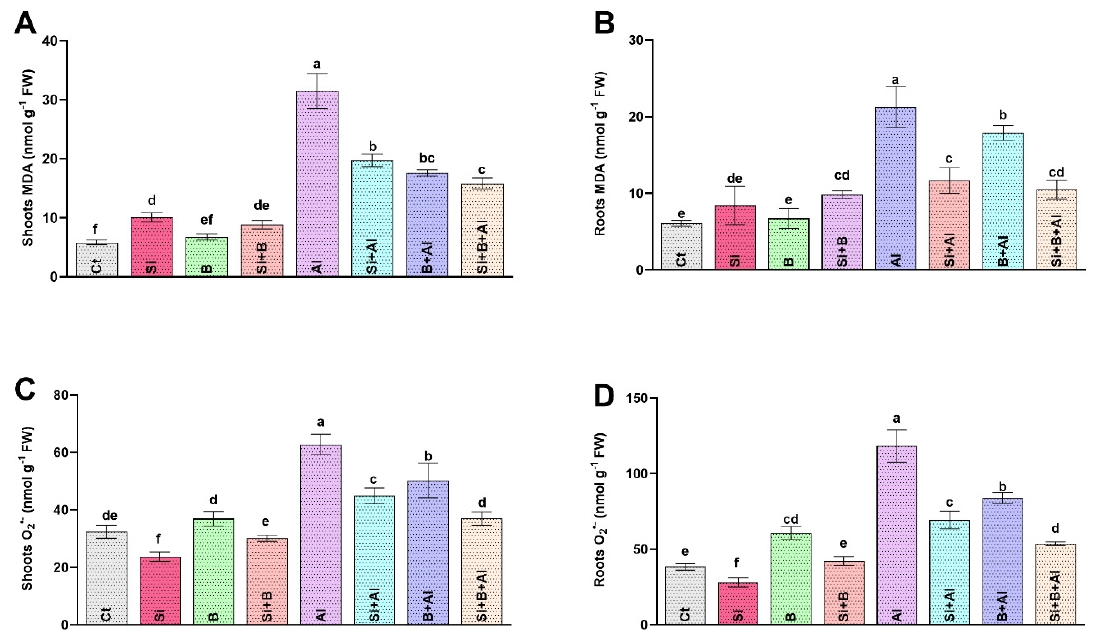
Figure 2. The effect of sole silicon (Si), boron (B), and their combination on ( A , B ) lipid peroxidation (malondialdehyde, MDA) and ( C , D ) superoxide anion (O 2 •− ) modulation under Al-induced toxicity in date palm roots and shoots. Bars with different letters describe statistically significant differences ( p < 0.05) between means by using one-way analysis of variance (ANOVA), followed by Duncan’s multiple range test (DMRT). Bars describe mean (of four replicates) ± standard